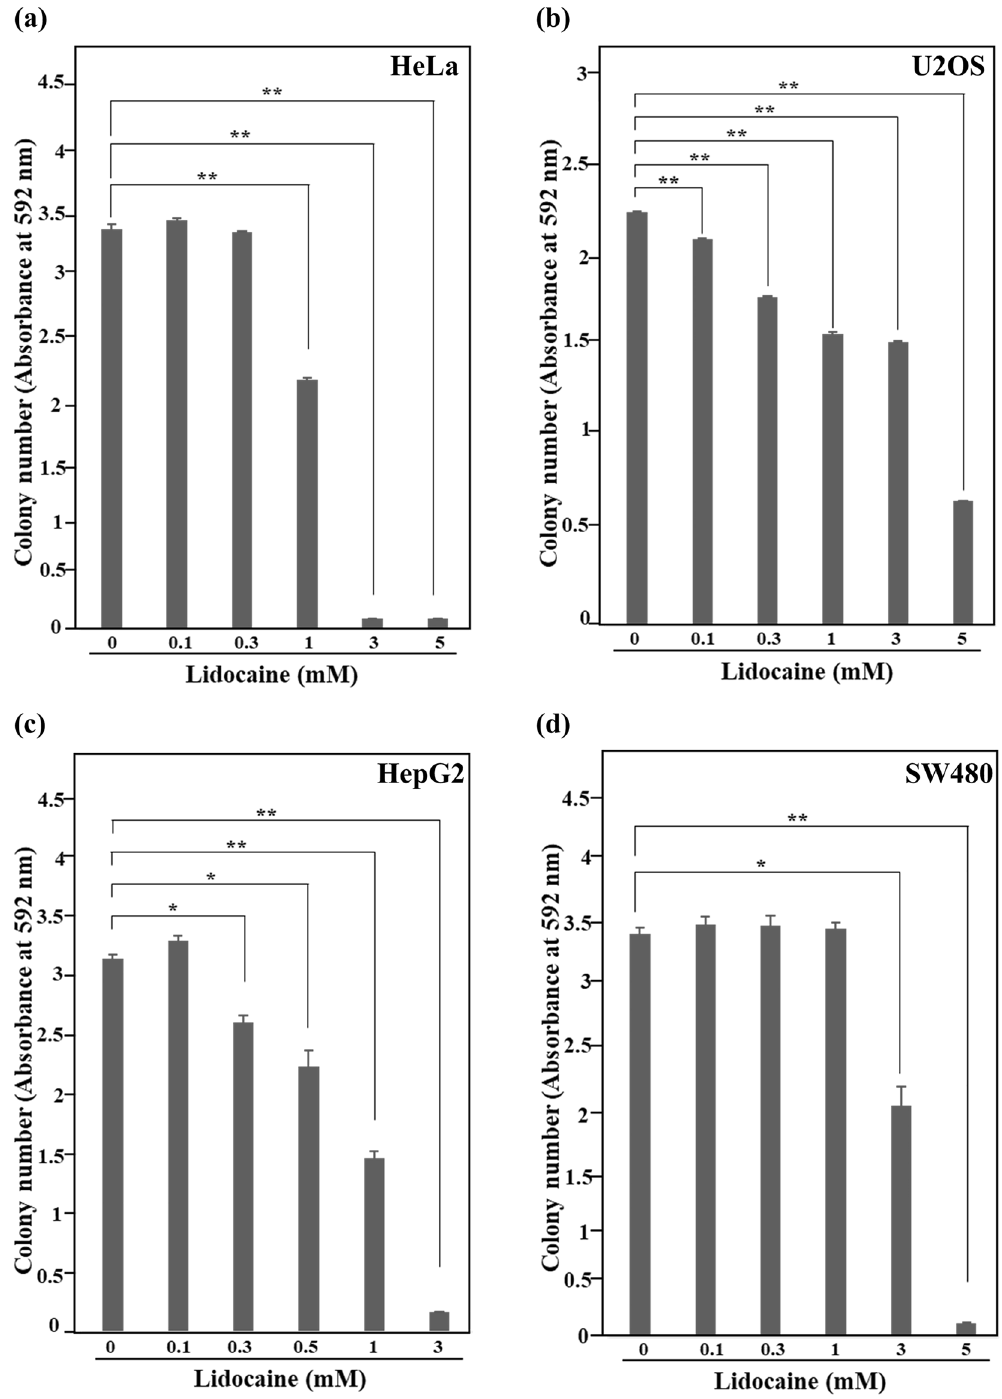
Figure 1. Growth suppression of cancer cell lines with lidocaine treatment. Colony formation assay. HeLa ( a ), U2OS ( b ), HepG2 ( c ) and SW480 ( d ) cells were treated with the indicated concentration of lidocaine and cultured for 7 days. The growth of each cell line was inhibited by lidocaine treatment in a concentration dependent manner. Each sample was assayed in triplicate and the results are presented as the mean ± SD. * p < 0.05, ** p <